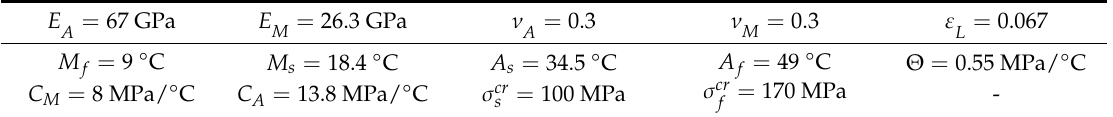
Table 1. Material parameters for the model verification